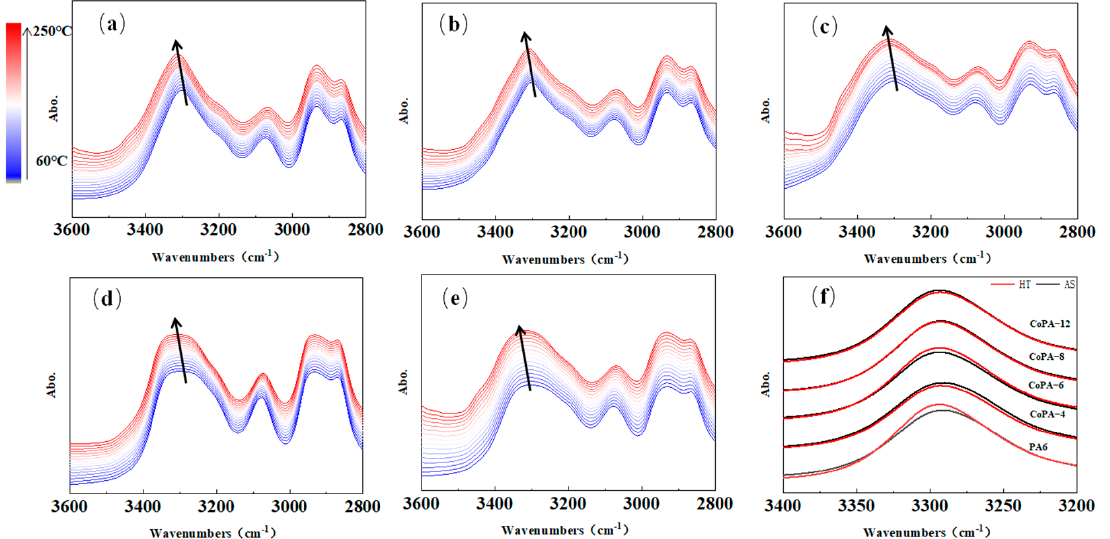
Figure 7. In-site temperature-variable FTIR spectra for polyamide 6 AS fibers ( a ), CoPA AS fibers under the wavenumber varying from 3600 cm − 1 to 2800 cm − 1 ( b – e ), and ATR-FTIR spectra for AS and HT of PA6 and CoPAs at 25 ◦ C ( f ) from 3400 cm − 1 to 3200 cm − 1 . According to Figure 7, the N–H stretching bond for PA6, centered at 3294 cm − 1 at room temperature, shifted to a higher wavenumber and became wider with increased temperature. Since the hydrogen − bonded N − H stretching band reflects both the crystal- line phase and amorphous phase [13], different methods were used for the analysis of the special bonds.